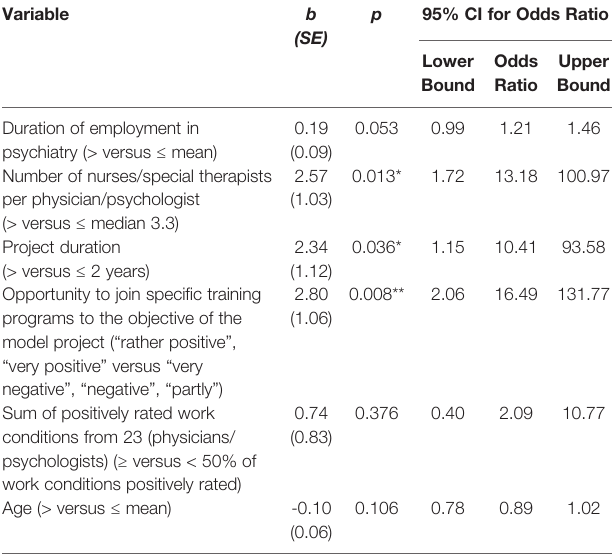
TABLE 3 | Results of the bivariate Spearman analysis for individual, organizational, structural characteristics, and the evaluations (EV) of physicians/ psychologists and nurses.